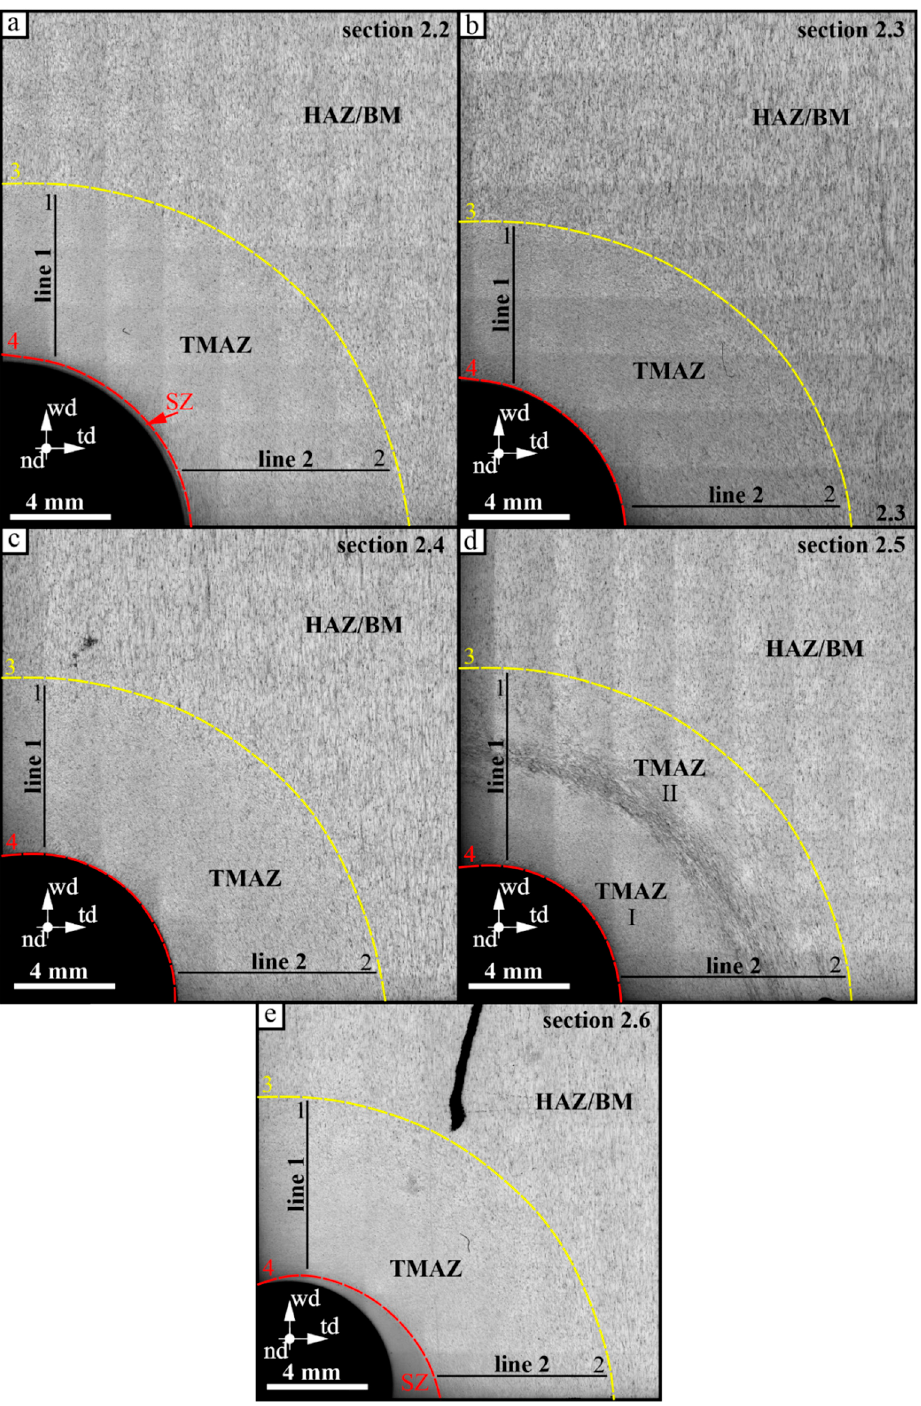
Figure 5. The microstructural evolution on stir zone (SZ), thermomechanically-a ff ected zone (TMAZ), heat-a ff ected zone (HAZ) and base metal (BM)microstructures near the exit hole leading edge on the advancing side (AS), as seen in plane sections 2.2 ( a ), 2.3 ( b ), 2.4 ( c ), 2.5 ( d ), and 2.6 ( e ) (Figure